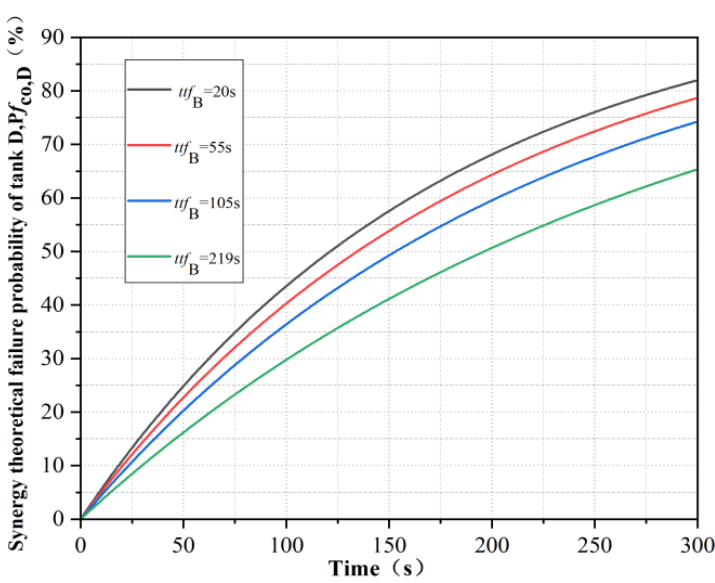
Figure 9. Real-time failure probability of tank D under the synergistic effect of tanks A and B. If tank C failed first under the synergistic thermal effect of tank A and tank B, the successive failure times of tanks B and C, under this working condition, could be obtained, according to the Monte Carlo simulation results, so as to calculate the theoretical failure time ttf co,D of tank D under the synergistic effect of the three failed tanks, as shown in Figure 10.